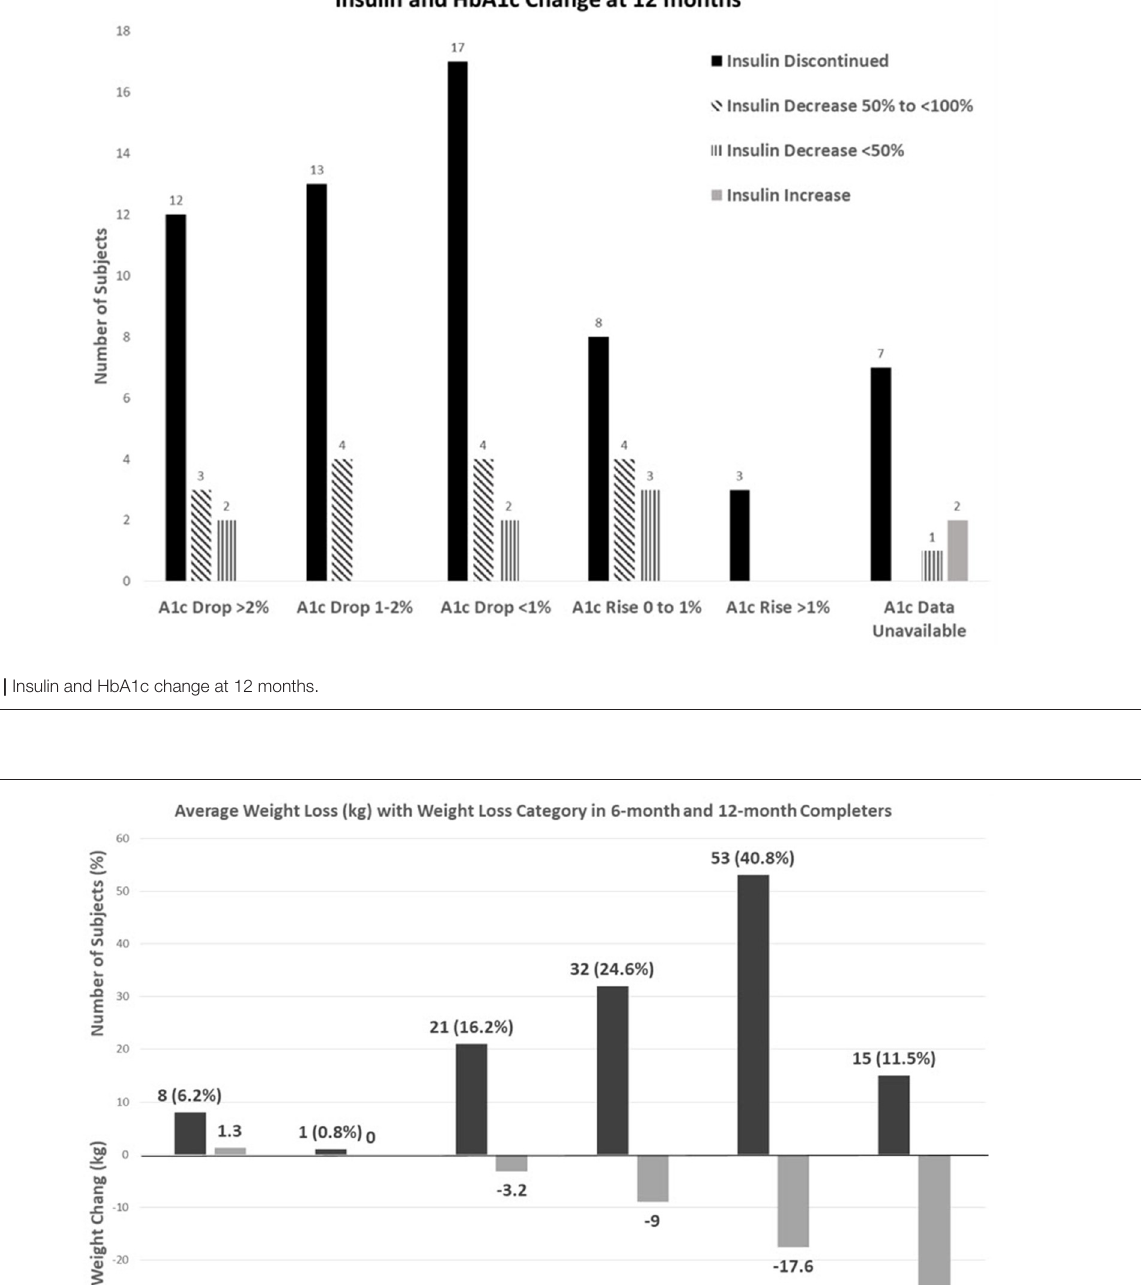
Frontiers in Nutrition |